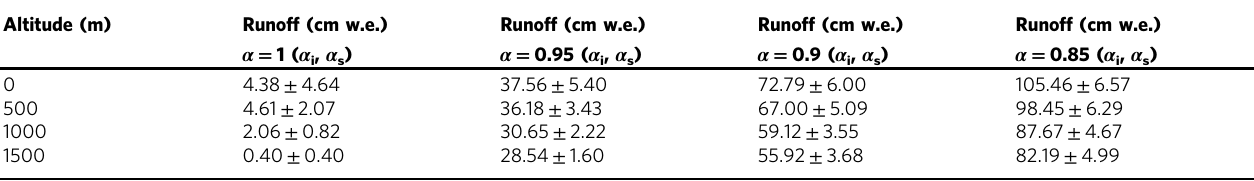
Table 4 Modeled change in runoff in response to a winter high-latitude eruption Altitude